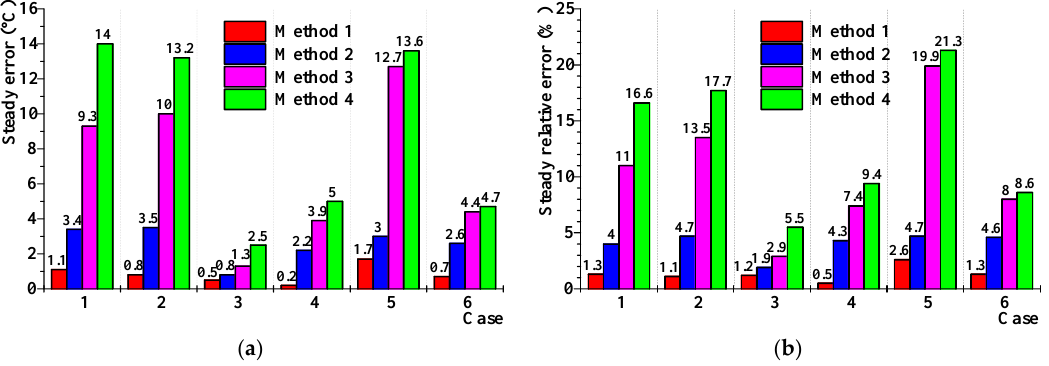
Figure 11. Calculation errors of steady conductor-temperatures based on different radial position temperatures: ( a ) errors and ( b ) relative errors.